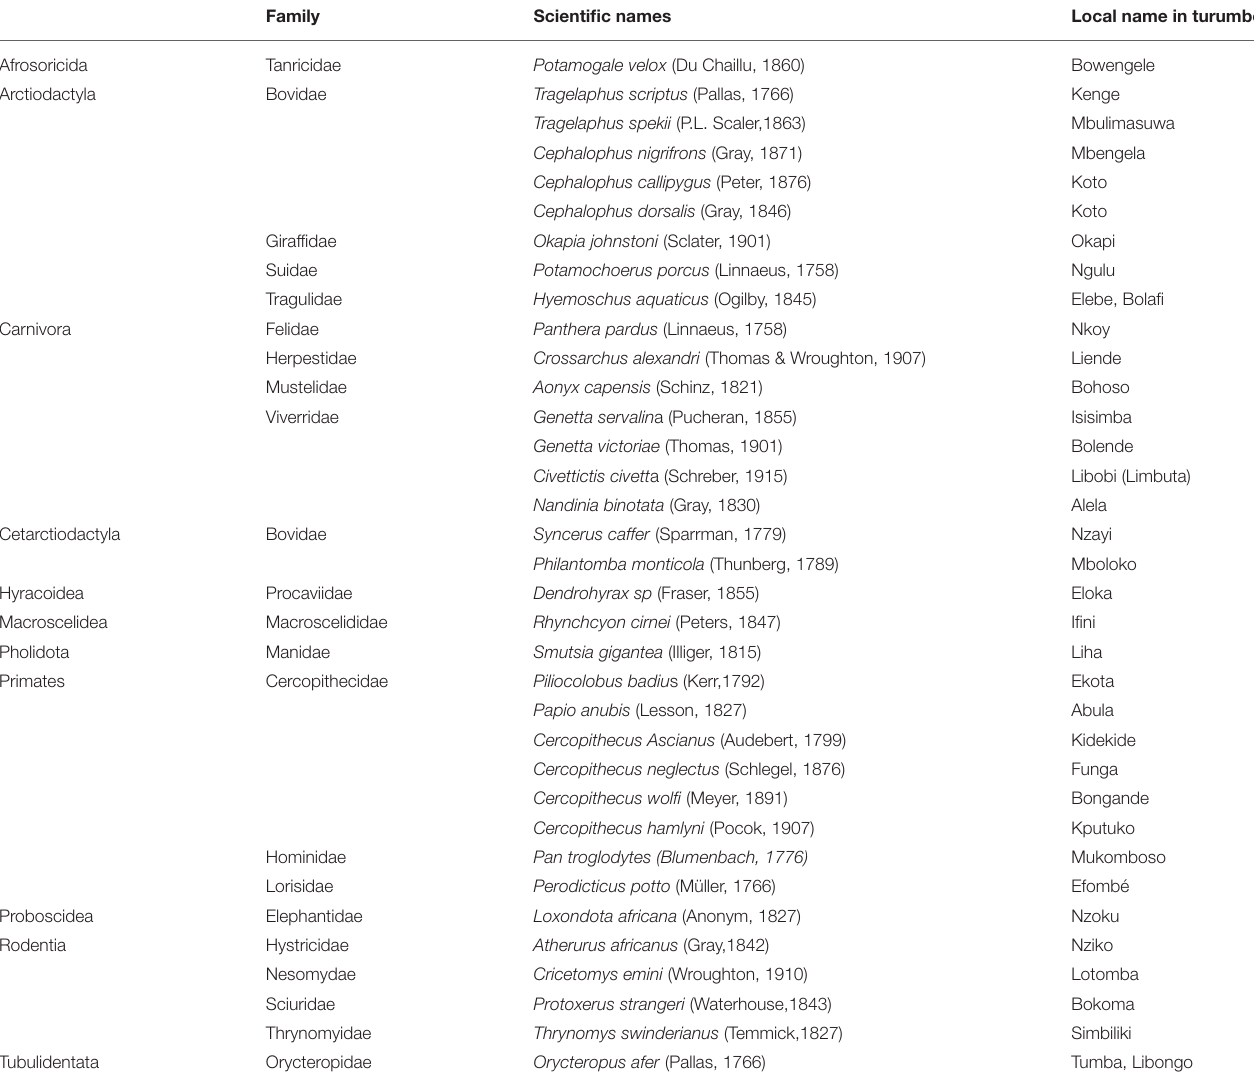
TABLE 3 | List of species traded as wildmeat in